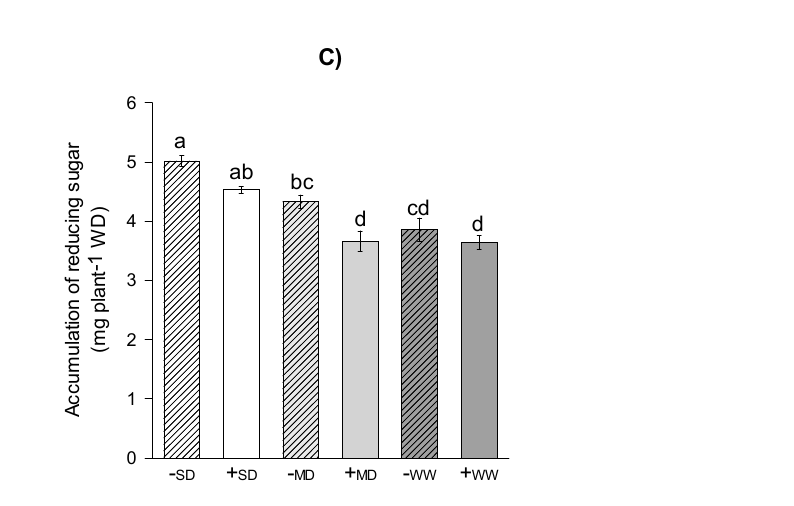
Figure 5. Total soluble sugar ( A ), non-reducing ( B ) and reducing ( C ) sugar of H. serratifolius plants submitted to different water regimes in the presence and absence of arbuscular mycorrhizal fungi. -SD: severe water deficit without AMF; +SD: severe water deficit with AMF; -MD: moderate water deficit without AMF; +MD: moderate water deficit with AMF; -WW: well-watered without AMF; +WW: well-watered with AMF. The means of variables with the same letter are not statistically different by Tukey’s test ≤ 5%.